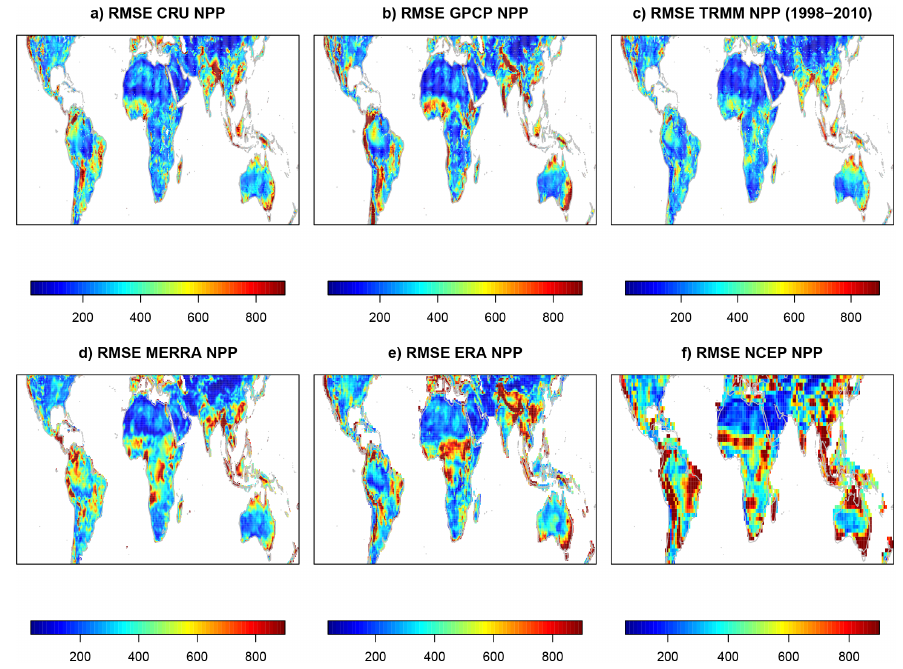
Figure 5. Root mean square error ( E RMS ) from the model NPP P − (β 1 NDVI ) for the years 1982–1999 and 2000–2010. (a) CRU data, (b) GPCP data, (c) TRMM data, (d) MERRA Land reanalysis (showing larger E RMS throughout), (e) ERA Interim reanalysis showing a large E RMS south of the Sahara, and (f) NCEP/NCAR